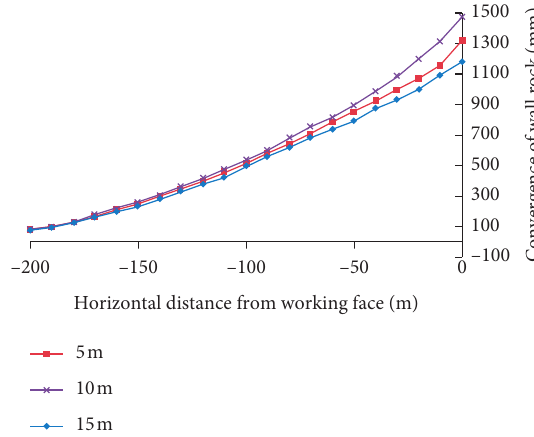
Figure 19: Horizontal displacement curves of two sides of roadway at different pillar